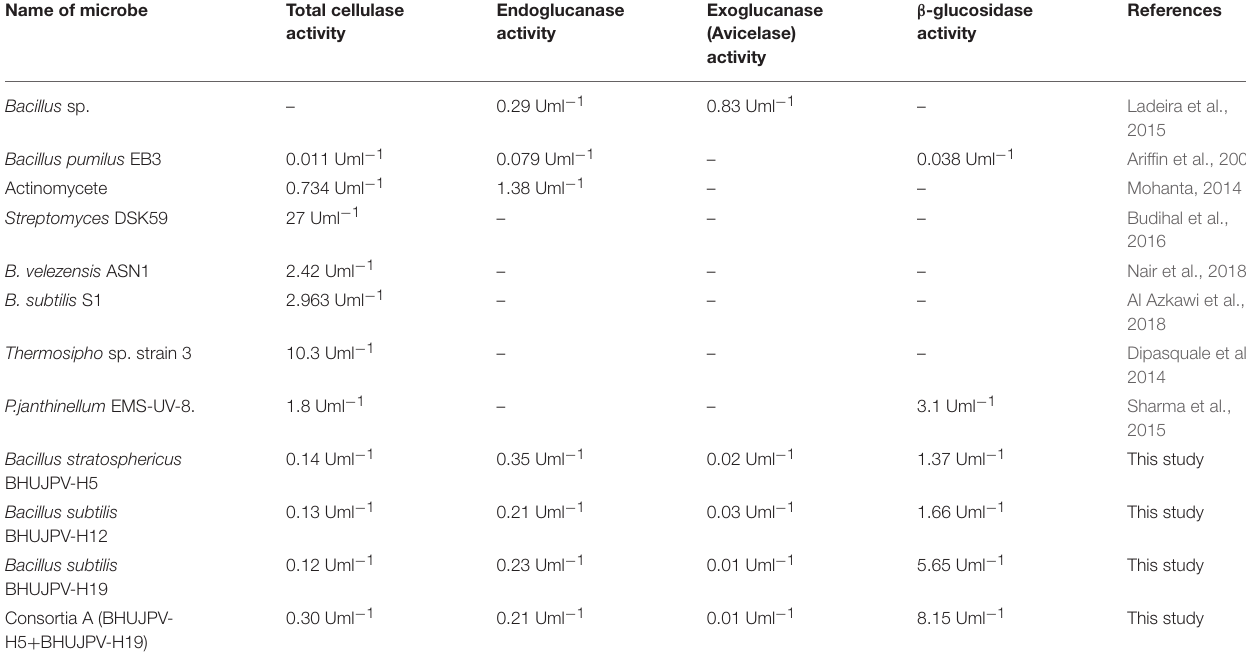
TABLE 3 | A comparative study of enzyme activities of different microbes in literature and present study. Name of microbe